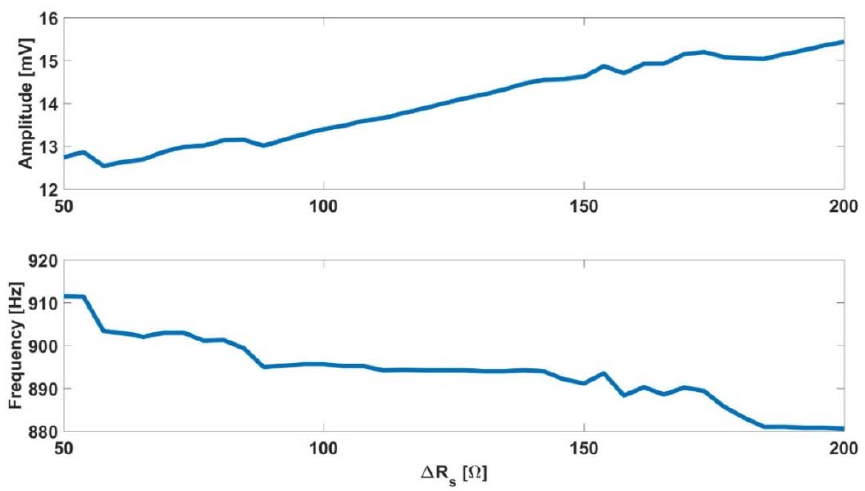
Figure A5. Variation of final oscillation amplitude and frequency as a function of Δ R s value.